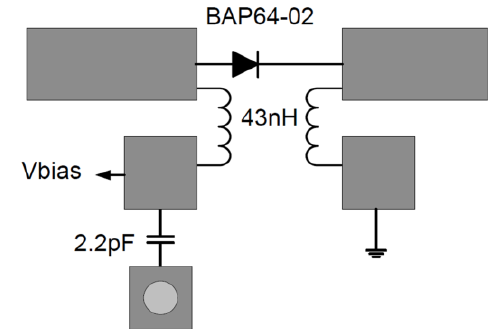
Figure 2: Biasing circuit for PIN diode.